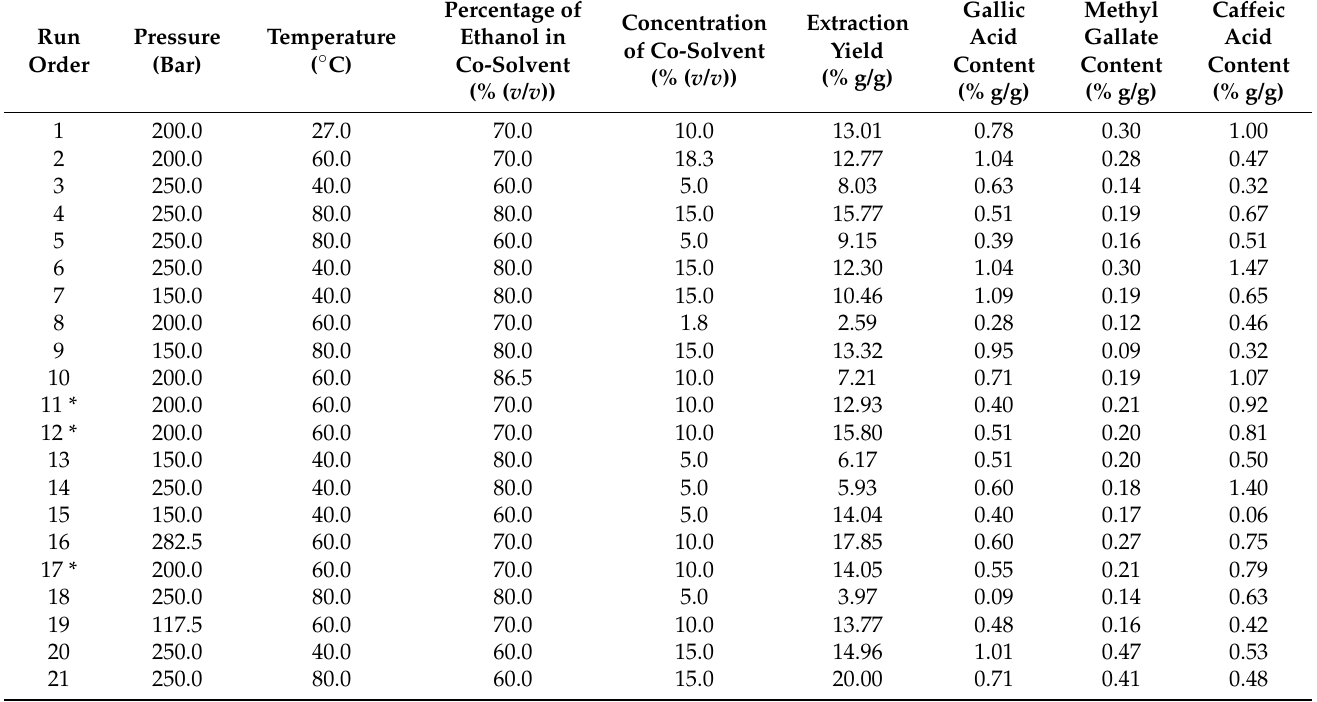
Table 1. CCD matrix of four variables with their observed responses using SC-CO 2 extraction ( α =